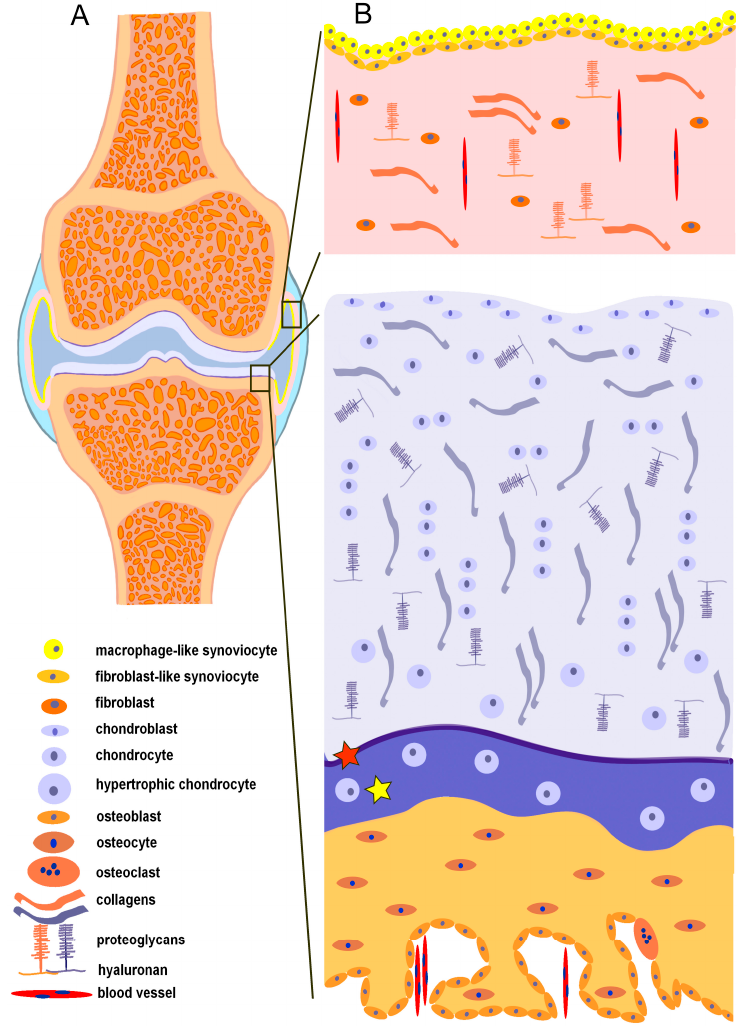
Figure 2. Schematic overview of a synovial joint structure. ( A ) Macroscopic view on the compartments of synovial joint. ( B ) The synovial membrane (upper part) in a healthy state. Composition of a healthy “osteochondral” unit (lower part), tidemark (red asterisk), and calcified cartilage (yellow asterisk).